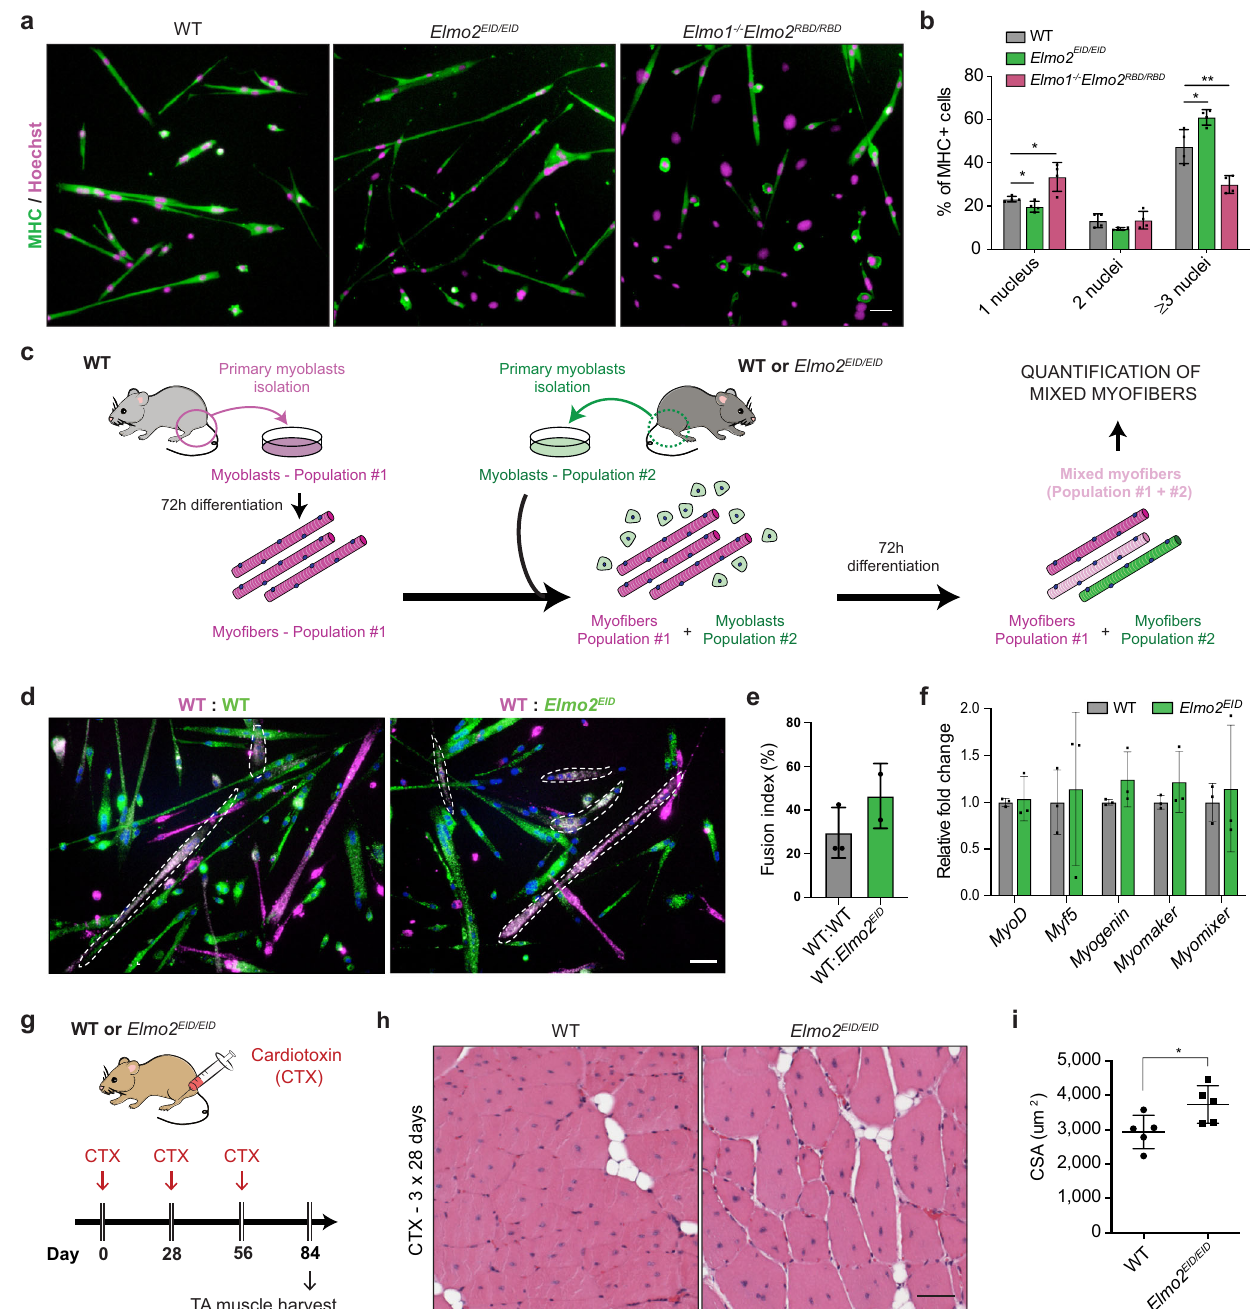
Fig. 4 | Manipulating ELMO2 conformational regulation regulates myoblast fusion in a cell intrinsic manner. a Fusion assay performed with primary myo- blastsisolatedfromtheindicatedmiceafter72hofdifferentiation.Myoblastswere stained with anti-MHC (green) and Hoechst (magenta) to reveal the nuclei ( n =4). b Quanti fi cation of ( a ) showing the fusion index of mononucleated (1 nucleus), binucleated(2nuclei)andmultinucleatedmyo fi bers( ≥ 3nuclei).Dataarepresented asthemeanvalues+/ − SD( n =4). c Schematicrepresentationofthemixpopulation assayperformedwithprimarymyoblastsisolatedfromtheindicatedmice.The fi rst population of primary myoblasts were stained with a red dye (represented here in magenta) and were differentiated for 72h. A second population of primary myo- blastsoftheindicatedgenotypeswerestainedwithagreendyeandaddedwiththe magenta myo fi bers. A second round of differentiation was induced for 72h and light pink myo fi bers (mixed myo fi bers) were quanti fi ed. d Mix population assay performed with primary myoblasts, as described in c . e Quanti fi cation of ( d )